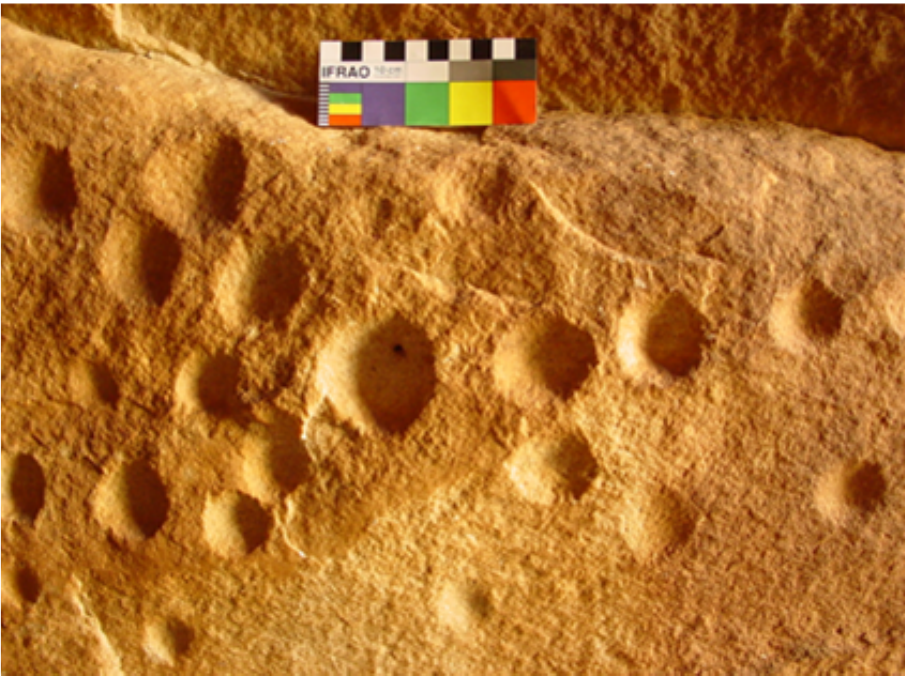
Figure 7. Small cupule with conical depth (section) in DC.